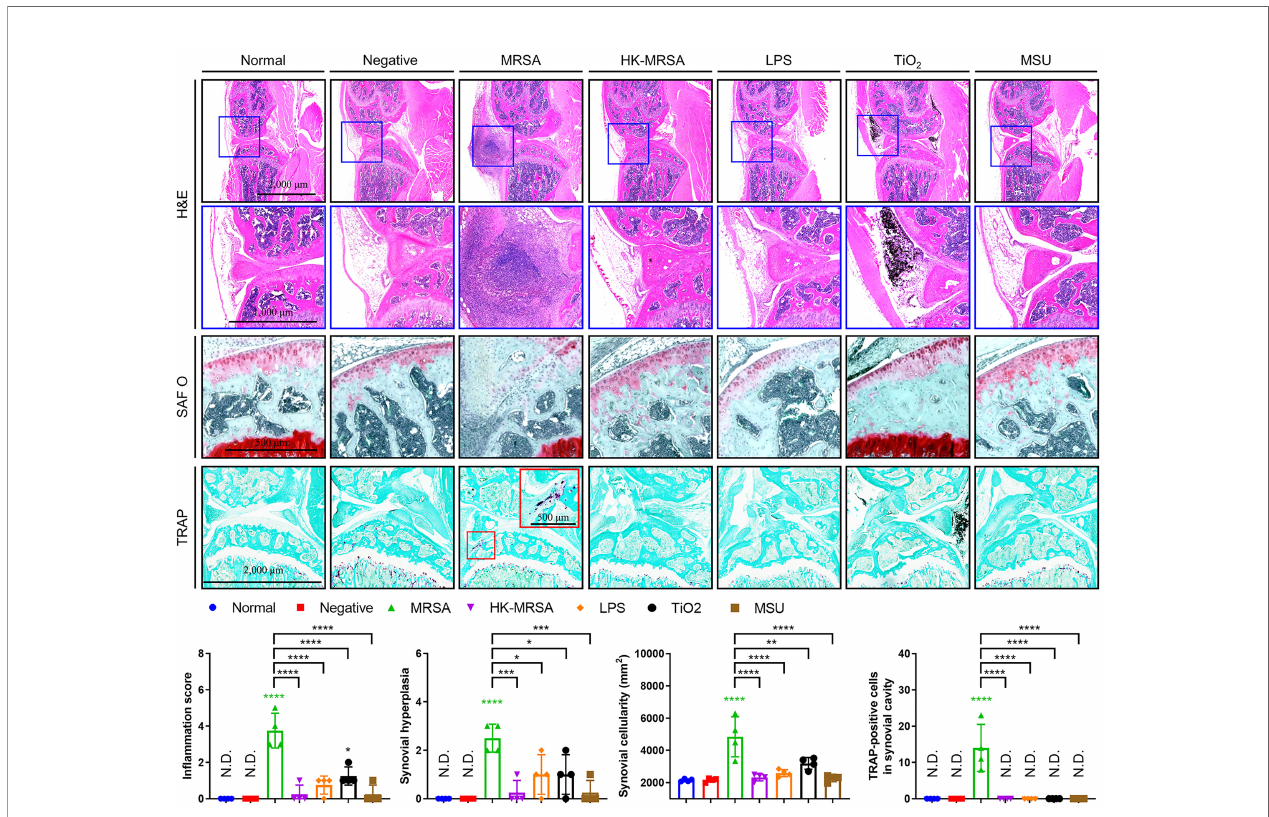
FIGURE 2 | MRSA Septic arthritis induced in fl ammation, destruction of articular cartilage, and osteolysis. C57BL/6 mice received intraarticular knee injections of either MRSA (1×10 5 CFU/10 m L), HK-MRSA (1×10 5 CFU/10 m L), LPS (200 µg/mL), TiO 2 (3 mg/mL), or MSU (200 µg/mL) with select mice receiving DPBS injection to serve as a negative control ( n = 4 per group). Ten days after inoculation, mice were sacri fi ced, and tissues obtained for histological analyses. Paraf fi n-embedded knee joint tissues were sectioned and histologically stained with H&E, SAF O, or TRAP (scale bars: 2,000, 1,000, and 500 m m). The in fl ammation score, synovial hyperplasia, synovial cellularity, and TRAP-positive cells were measured using H&E- and TRAP-stained images. Error bars show means ± SD. One-way ANOVA with Tukey ’ s post hoc analysis was used to assess statistical signi fi cance when compared to the negative control group or MRSA group (* p <0.05 or ** p < 0.01 or *** p < 0.001 or **** p < 0.0001; N.D., not